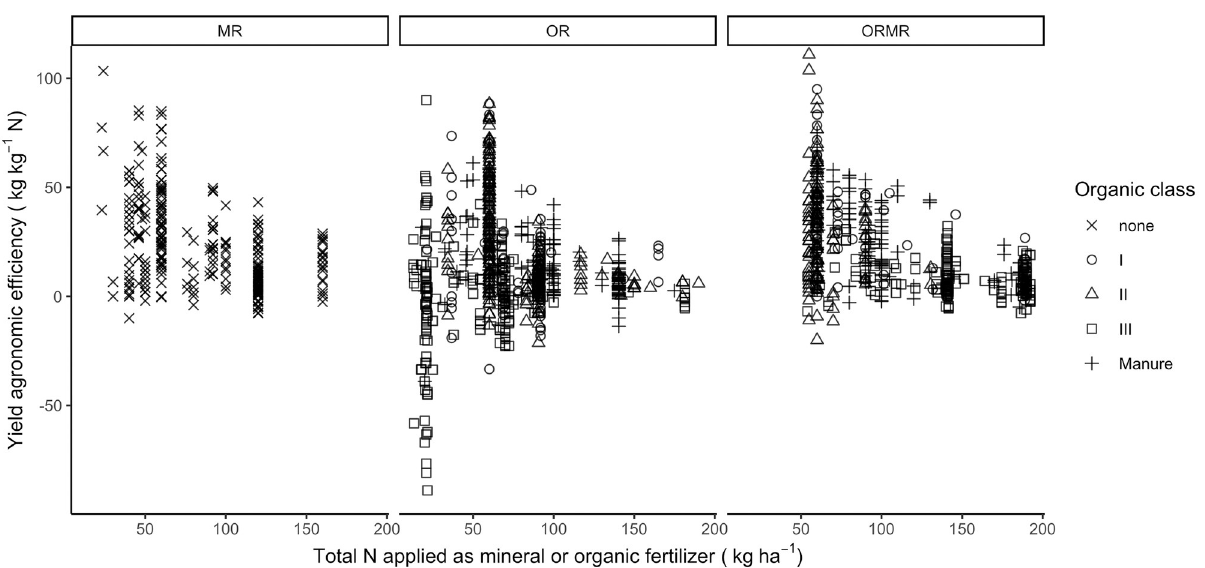
Fig 5. The agronomic efficiency (AE, in kg kgN -1 ) across a total N input range of 0-200 (kg ha -1 ), applied as mineral or organic fertilizer, and segregated by treatment and organic input quality class.